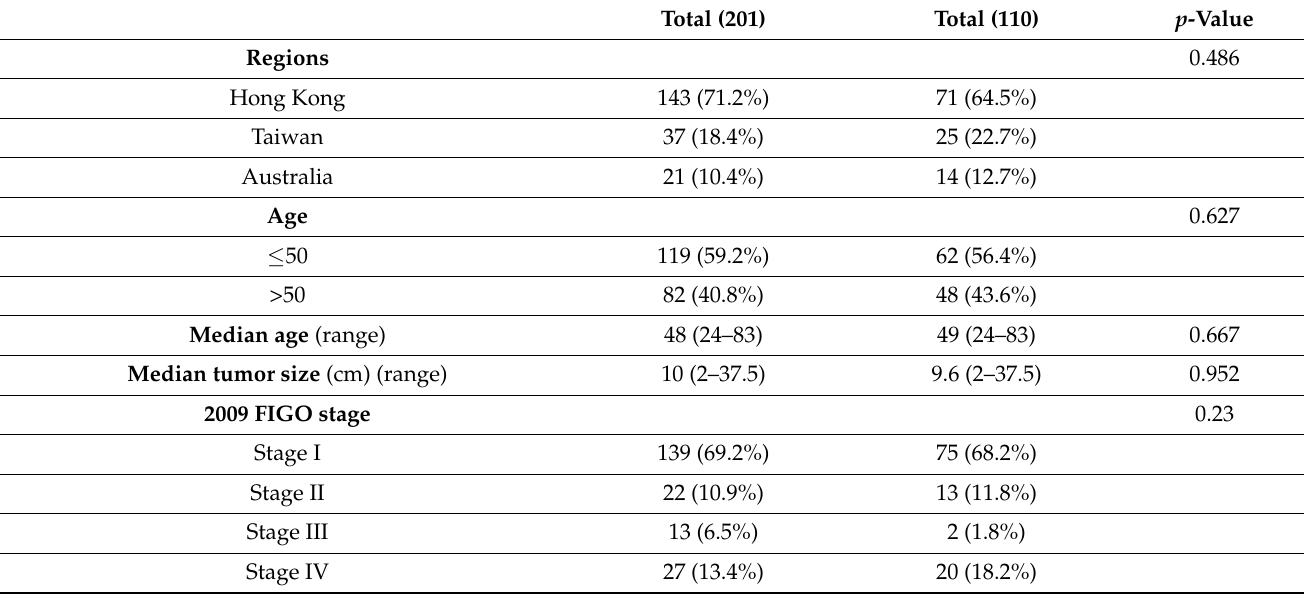
Table 1. Demographics data of the whole cohort and the 110 patients used to build the scoring